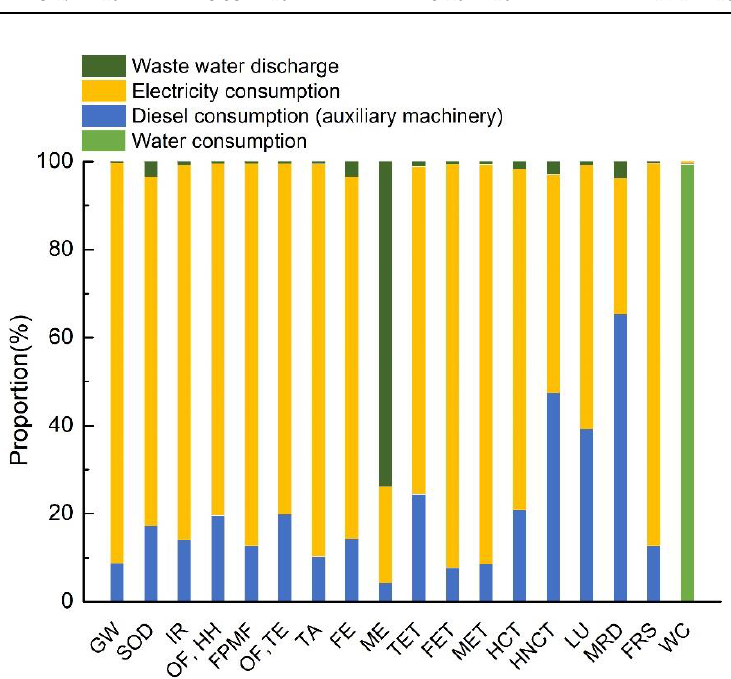
Figure 5. Normalized LCA results for Scenario 1.